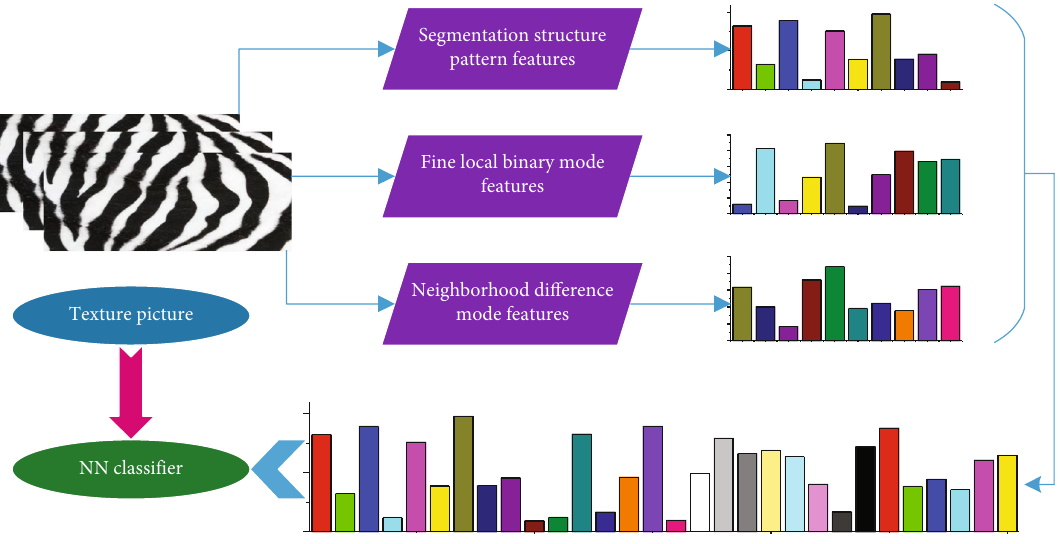
Figure 1: Flow chart of texture classi fi cation